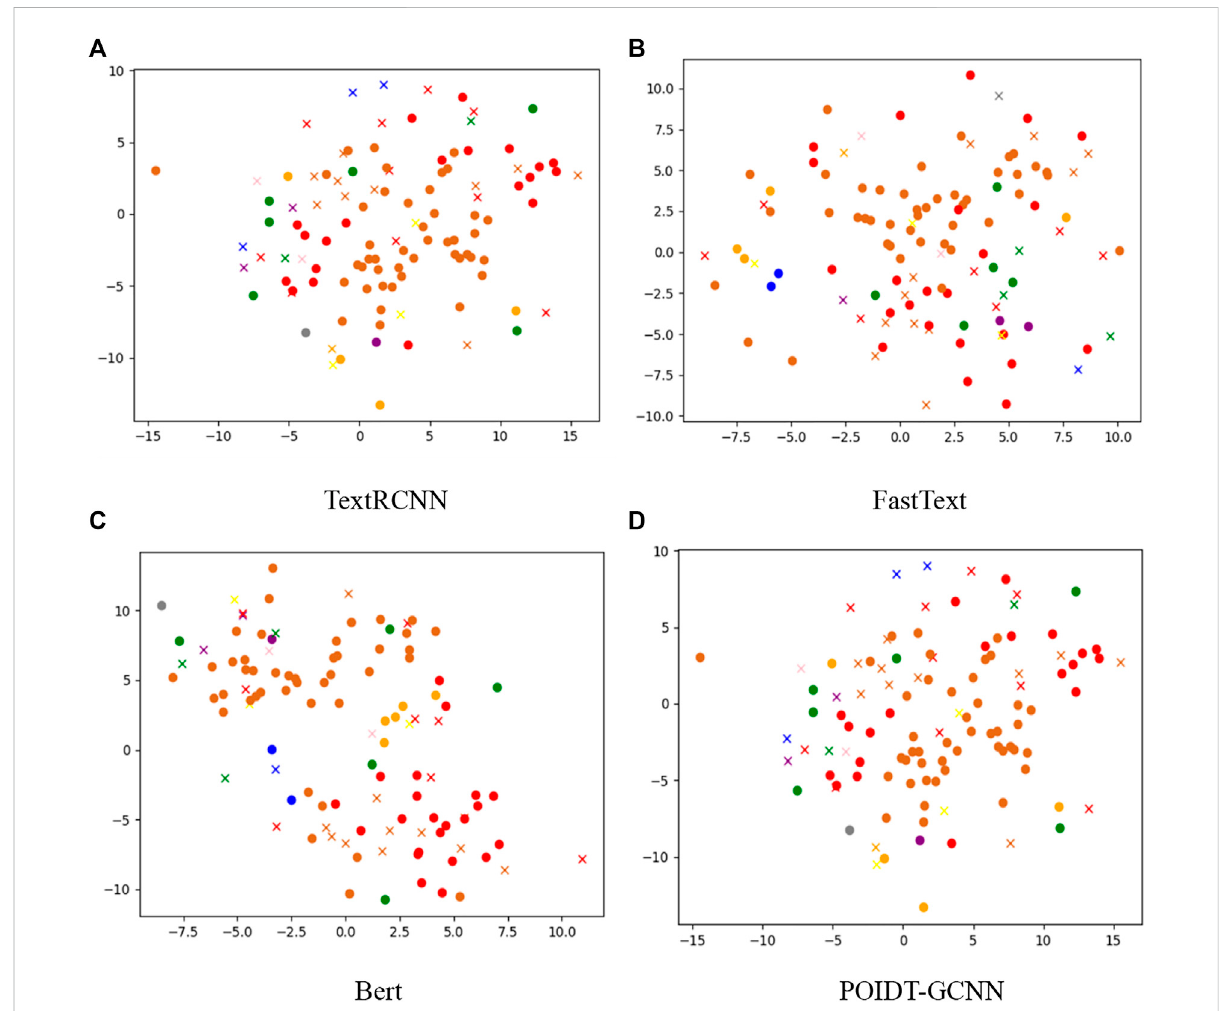
FIGURE 4 Defect text classi fi cation